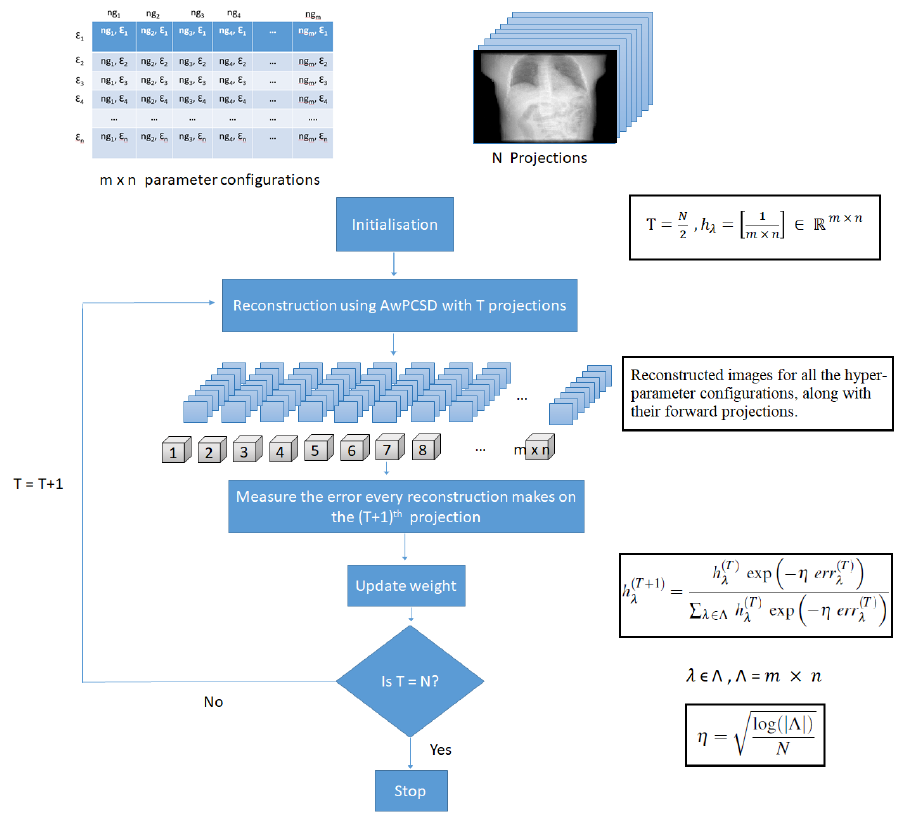
Figure 1. The proposed hyper-parameter selection